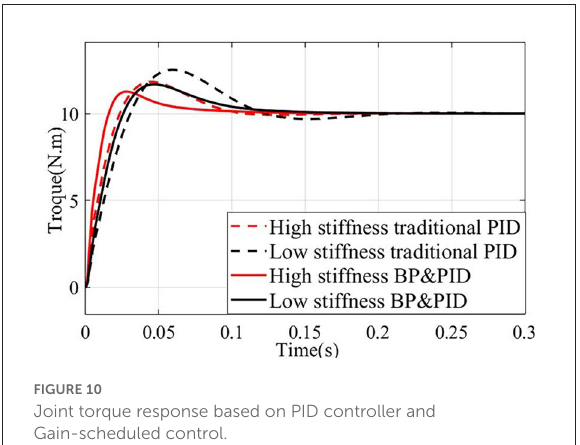
FIGURE10 Joint torque response based on PID controller and Gain-scheduled